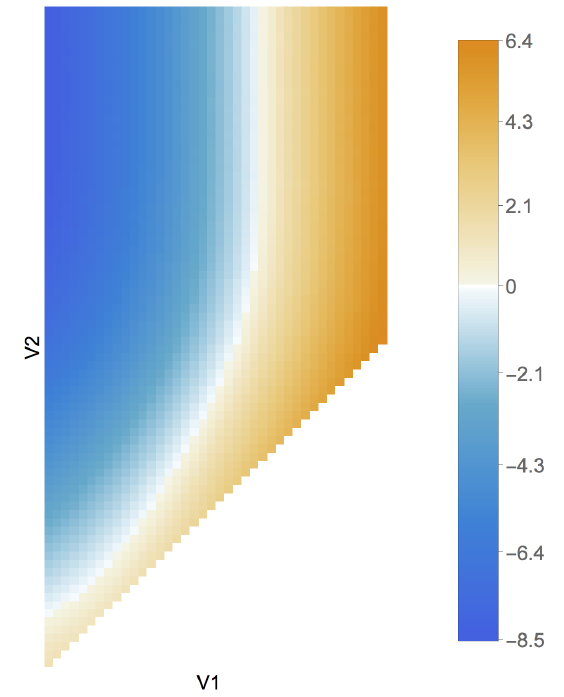
Figure 10: The figure above is a numerical computation which represents the value of the perimeter difference µ ( V 1 , V 2 ) for the smoothed out exponential density (5.1) . The orange color marks the region in which the double interval has less perimeter, the blue color represents the region in which the triple interval has less perimeter, and the white curve marks the tie point between the double and triple intervals. The plot indicates that the tie curve asymptotes to fixed value of V 1 . Computed in